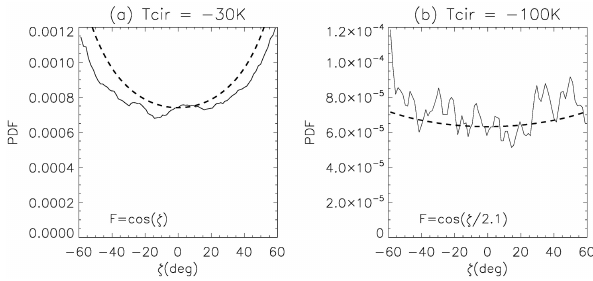
Figure A1. PDF of T cir in the range of [ − 100, − 99K] (a) and [ − 50, − 49K] (b) as a function of scan angle derived from a month of NOAA-18 MHS T cir data (December 2010). Thick solid curves are calculated from the mean PDF values averaged over the 10 nadir- view FOVs divided by a factor of cos (ζ/ 2 . 1 ) (a) and cos ζ (b) , re- spectively, and are used to fit the observed PDF curves. ζ is the zenith